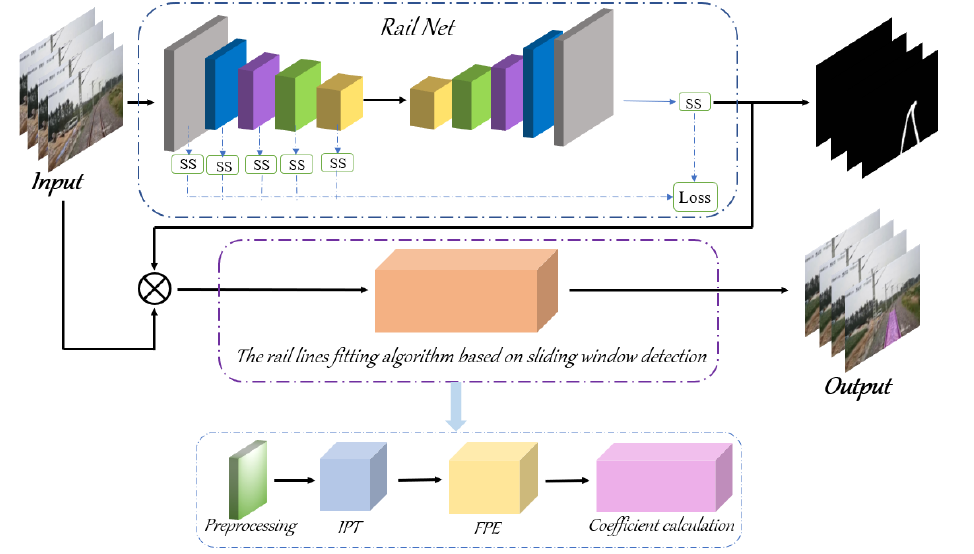
Figure 1. Overview of the proposal method.The RailNet part is responsible for extracting the rail lines features, which is trained to generate the binary segmentation maps of the rail lines. Afterward, the binary segmentation maps and the original images are processed by the rail lines fitting algorithm based on sliding window detection part. IPE and FPE respectively stand for Inverse Perspective Transformation and Feature Point Extraction of the rail lines. A second-order polynomial is fitted for each rail line, and the rail lines are reprojected onto the original